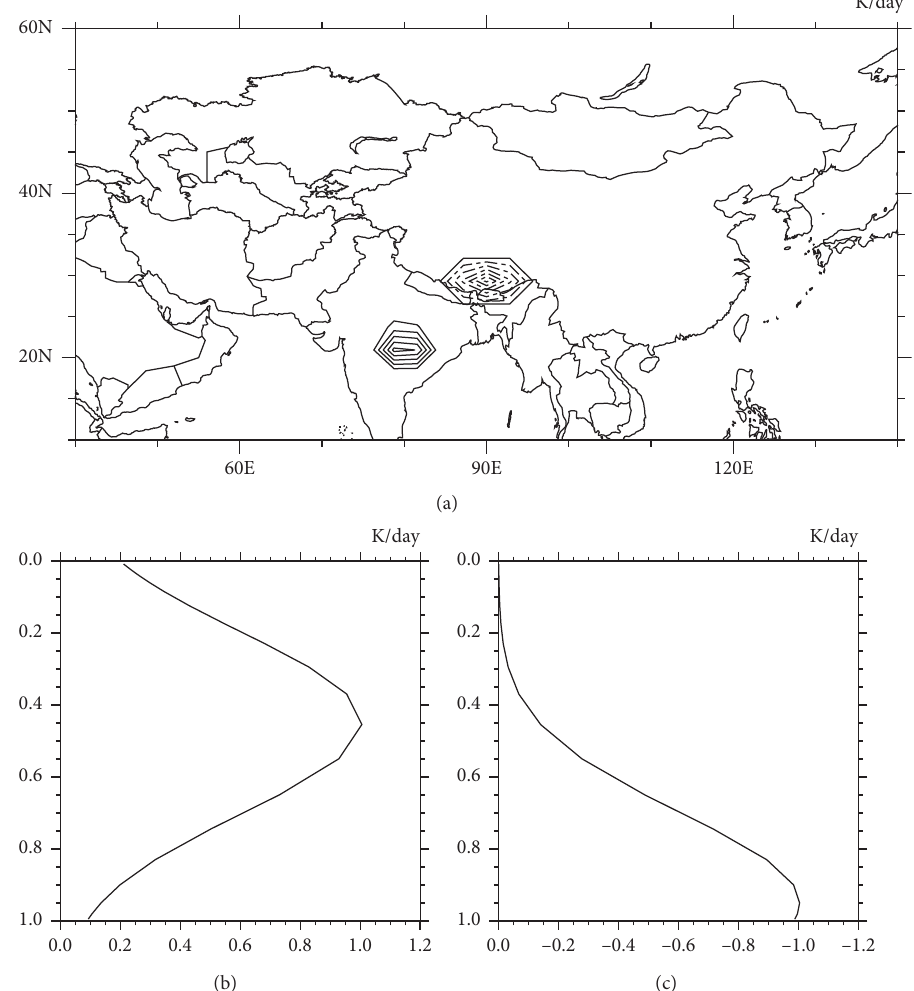
Figure 6: The (a) in-depth mean of diabatic heating anomalies in 80 ° E, 22 ° N and cooling anomalies in 90 ° E, 30 ° N (units: K · day − 1 ) and vertical profiles of forcing (units: K · day − 1 ) in (b) 80 ° E, 22 ° N and (c) 90 ° E, 30 ° N used to drive the LBM